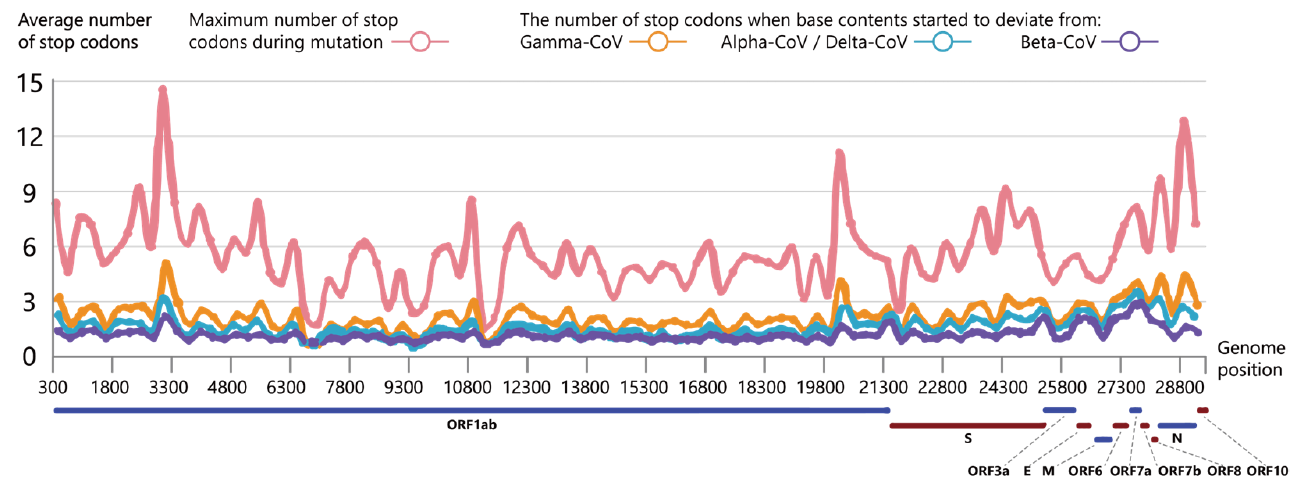
Figure 7. The distribution of new-generated stop codons during mutation simulation. The horizontal axis represents the locations of stop codons on SARS-CoV-2 gene segments and the vertical axis represents the average number of these stop codons within the window length (300 bases). Pink, orange, blue and purple lines represent the maximum number of stop codons during mutation (Method S3), the number of stop codons when base content percentage start to deviate from Gamma-CoV, Alpha-CoV /Delta-CoV and Beta-CoV, respectively.